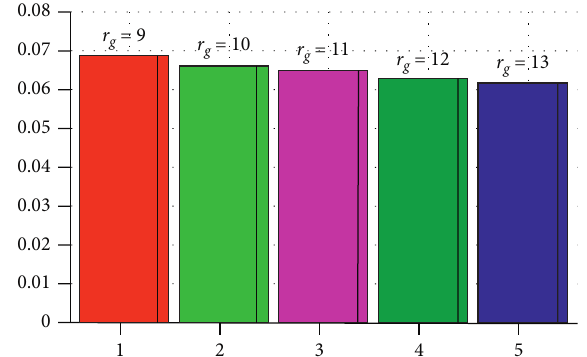
Figure 9: Comparison of the accumulative error for state x choosing different c g